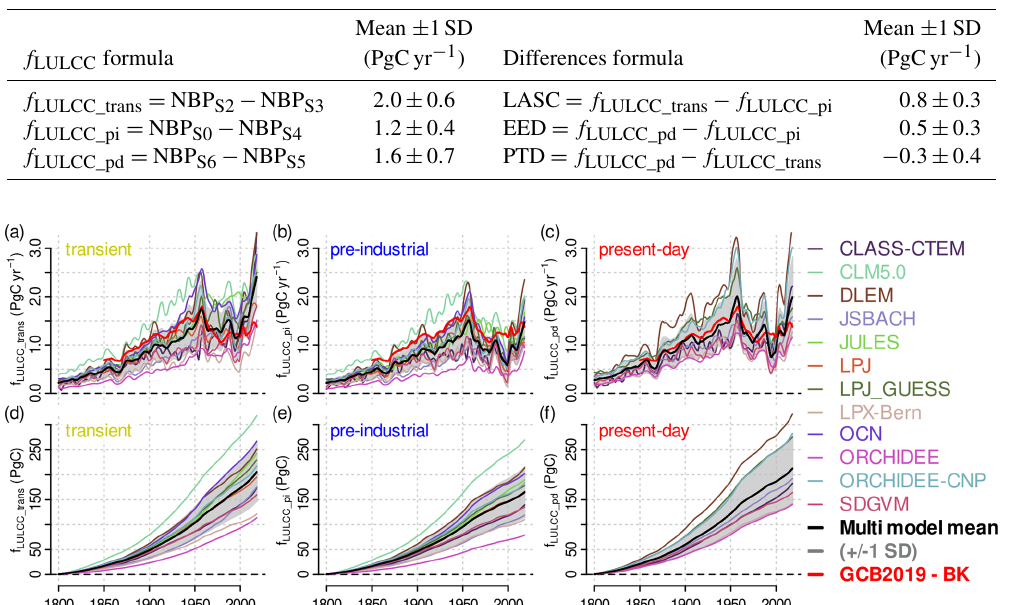
Figure 3. Smoothed global annual means (a–c) and cumulative sums (d–f) of f LULCC_trans (a, d) , f LULCC_pi (b, e) , and f LULCC_pd (c, f) for the investigated DGVMs from 1800 to 2018. For the derivation formulas refer to Eqs. (1) to (3) and for discussion of individual models refer to Sect. A1. f LULCC_pd was not derived for CLM5.0, JULES, LPJ, and OCN (compare Table 2). For comparison, we also included the GCB2019 bookkeeping mean (same values in all panels).